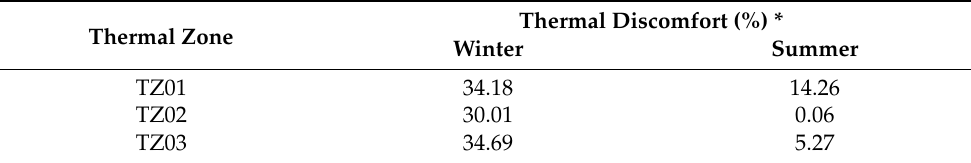
Table 6. Thermal discomfort—Reference scenario.